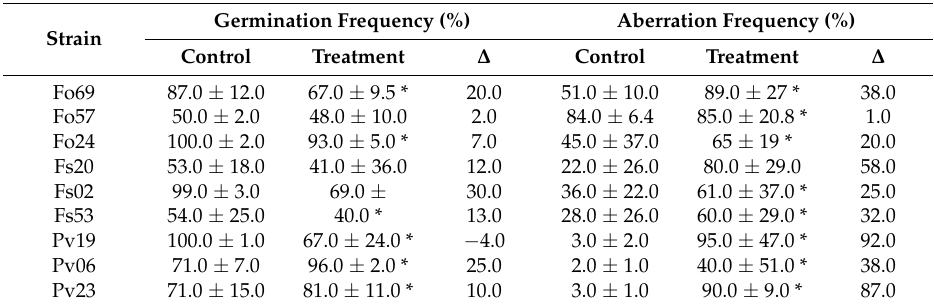
Table 2. Summary of results from the initial screening of the effect of A. striata filtrate on the average germination and aberration frequencies of three strains each of F. oxysporum (Fo69, Fo57, and Fo24), F. solani (Fs20, Fs02, and Fs53), and P. variotii (Pv19, Pv06, and Pv23).